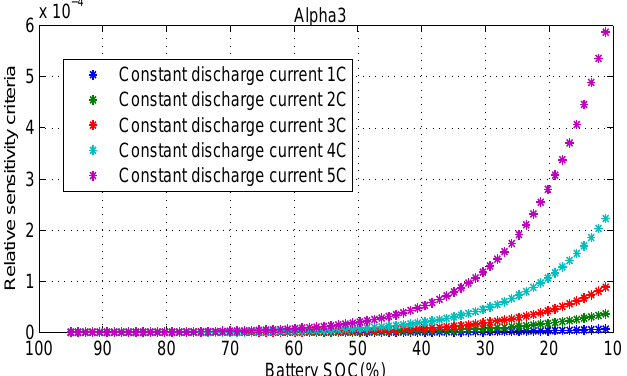
Figure 15. Analysis of index values under different current rates discharge test: the sensitivity index values of highly sensitive parameter fractional-order factor α 2 .